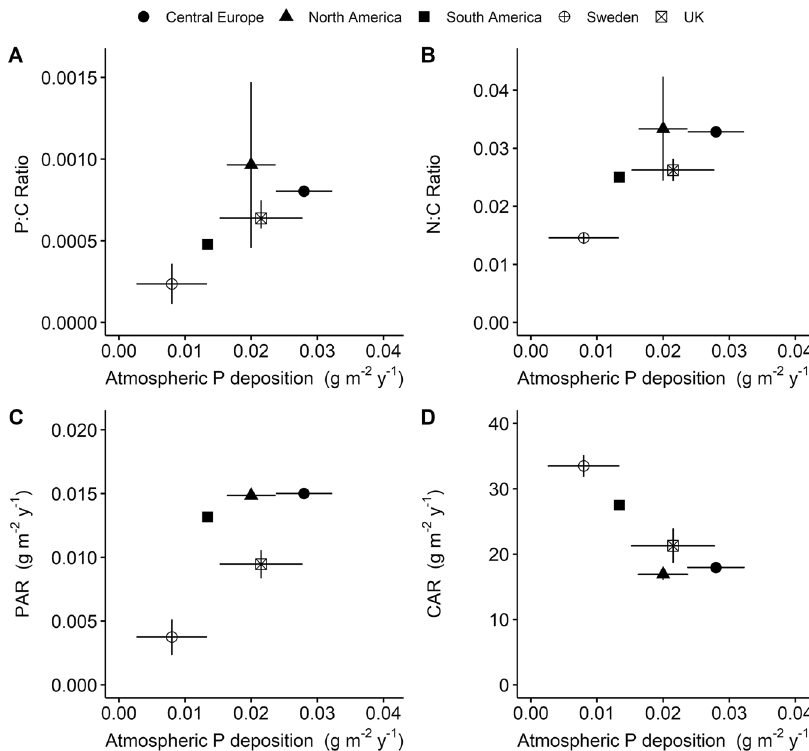
Fig. 5 Comparisons of modern measured atmospheric P deposition and peatland catotelm stoichiometry and C burial. The positive associations between P deposition and catotelm P:C ( A ) and PAR ( C ) fi t our expectations because phosphorus depends exclusively on external supply. The negative relationships observed between P deposition, the intensity of decomposition (inferred from the N:C ratio; ( B )) and rates of catotelm carbon burial ( D ) are more notable, pointing to an effect of P supply on carbon dynamics. Data points are regional median± standard error. Atmospheric P deposition (P dep ) represents the median of between 1 and 28 monitoring stations to account for local variance and bars represent standard errors where more than one monitoring station was used (see Fig. 1 and ‘ Methods ’ ). The equivalent values for acrotelm peats are presented in Supplementary Fig. 4 and show similar